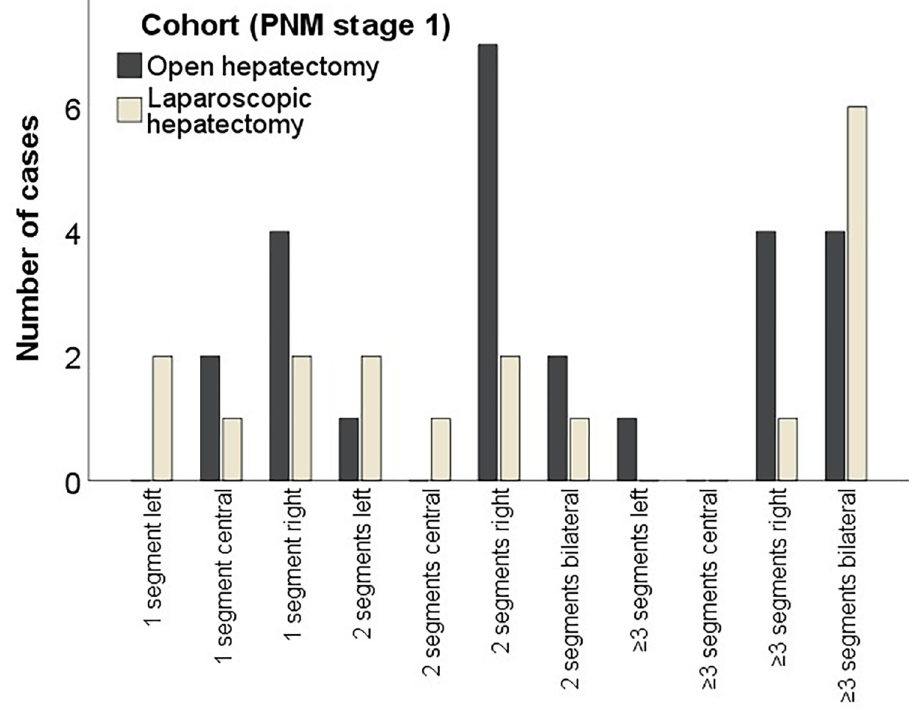
Fig 5. Location of hepatic AE lesions according to surgical approach of PNM stage 1